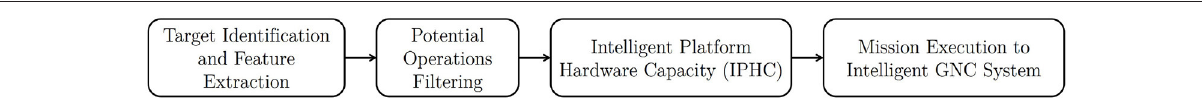
FIGURE 3 | The decision-making flow chart for the intelligent Guidance, Navigation, and Control (GNC) system. The achievable tasks are based on the hardware constraints and the task is selected based on the target’s identify and features.